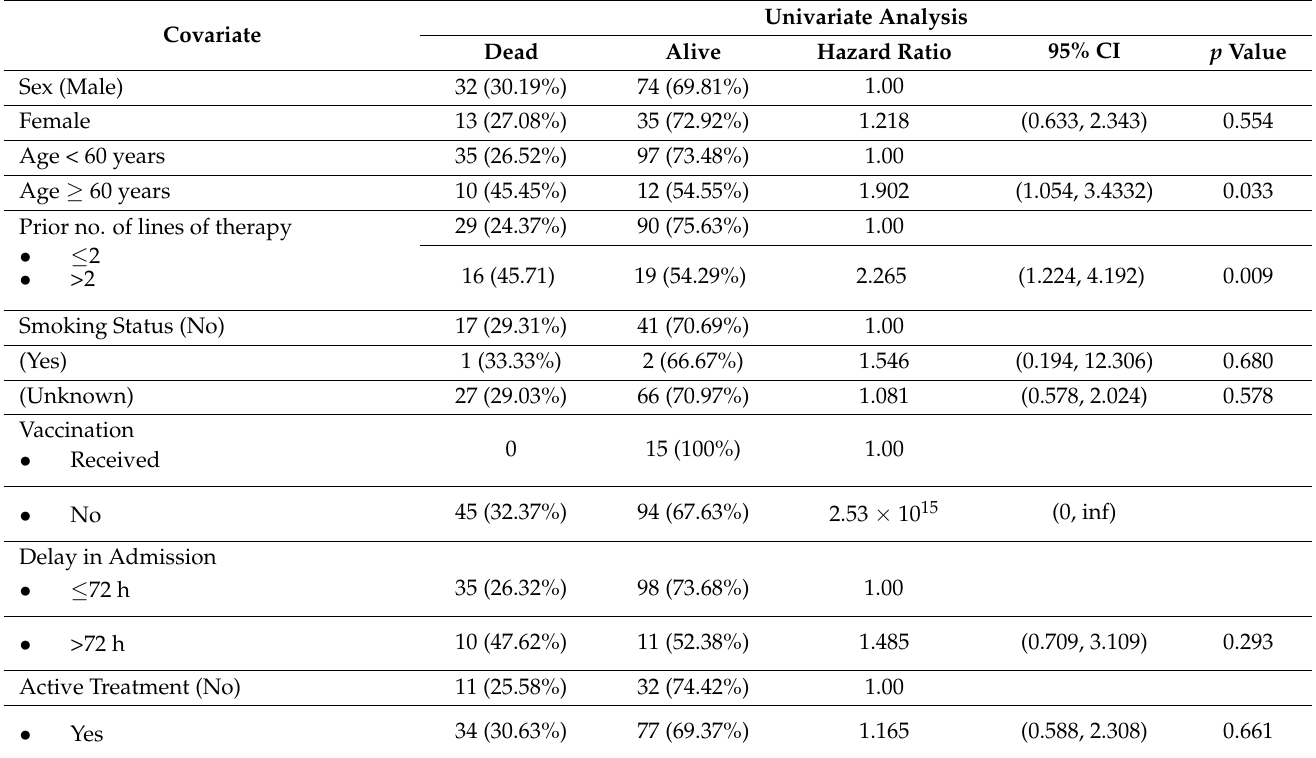
Table 2. Predictors of survival from Univariate analysis for the Delta